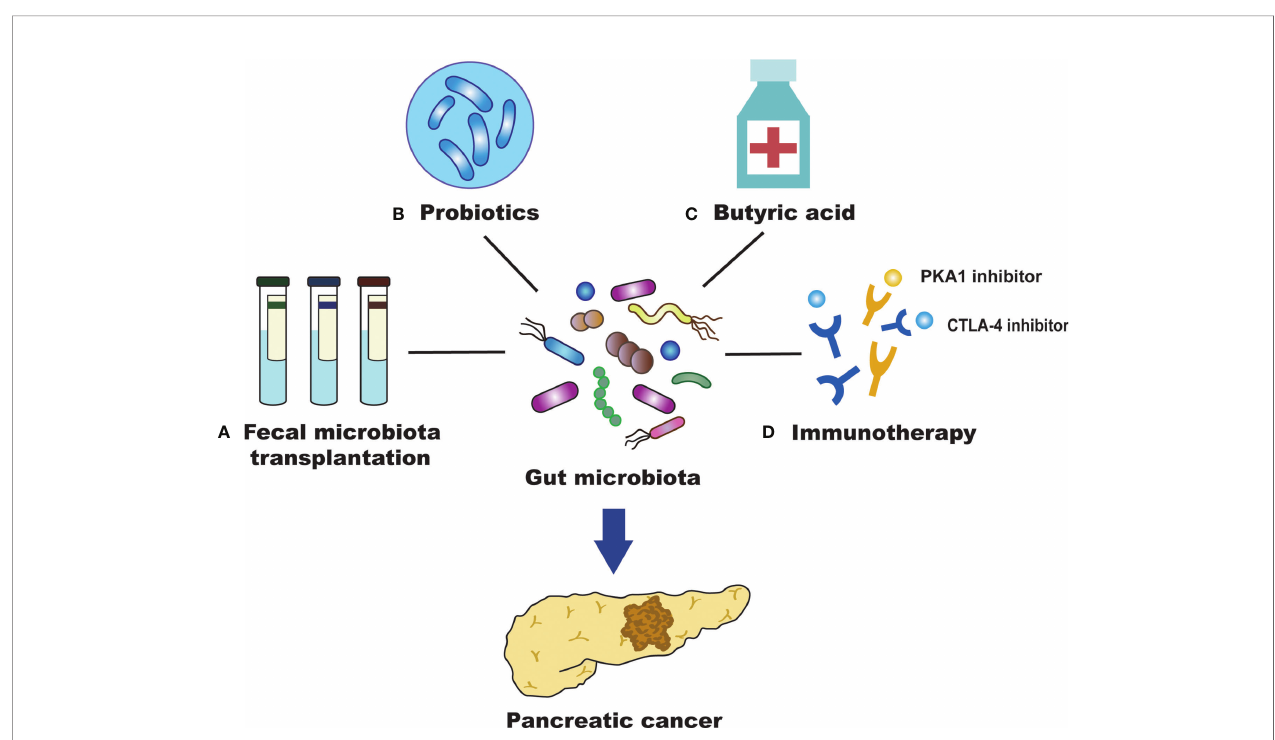
FIGURE 2 | Ef fi cient treatment for PC by targeting the gut microbiota. (A) Fecal microbiota transplantation (FMT) may inhibit the development of pancreatic cancer (PC) by regulating the intestinal microbiota, reducing the production of in fl ammatory mediators and cytotoxic metabolites, and improving the dysregulation of intestinal microbiota. (B) Probiotics may alter gut microbiota and affect the survival of patients with PC. They can also promote human health with antitumor effects and maintain the homeostatic state of intestinal microorganisms. (C) Butyric acid can promote the differentiation of PC cells and inhibit their invasion and metastasis of PC cells. (D) The gut microbiota can promote anti-PC immunotherapy by regulating immune checkpoints (PD-L1 and